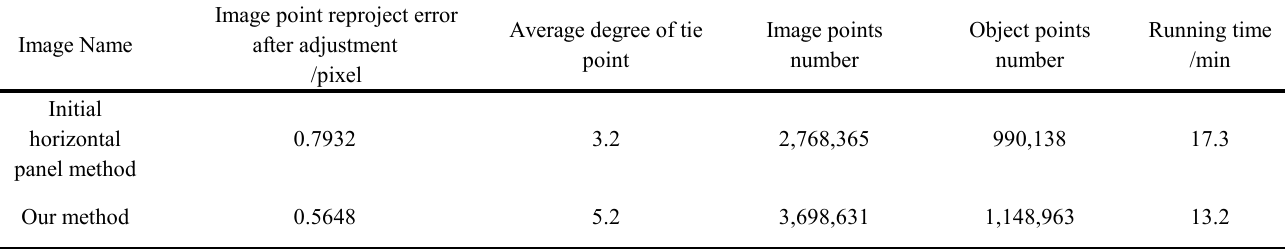
Table4. Matching results and matching efficiency comparison